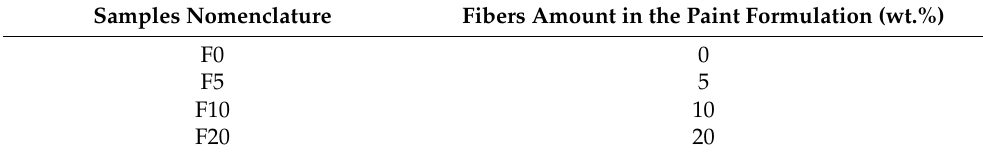
Table 1. Samples